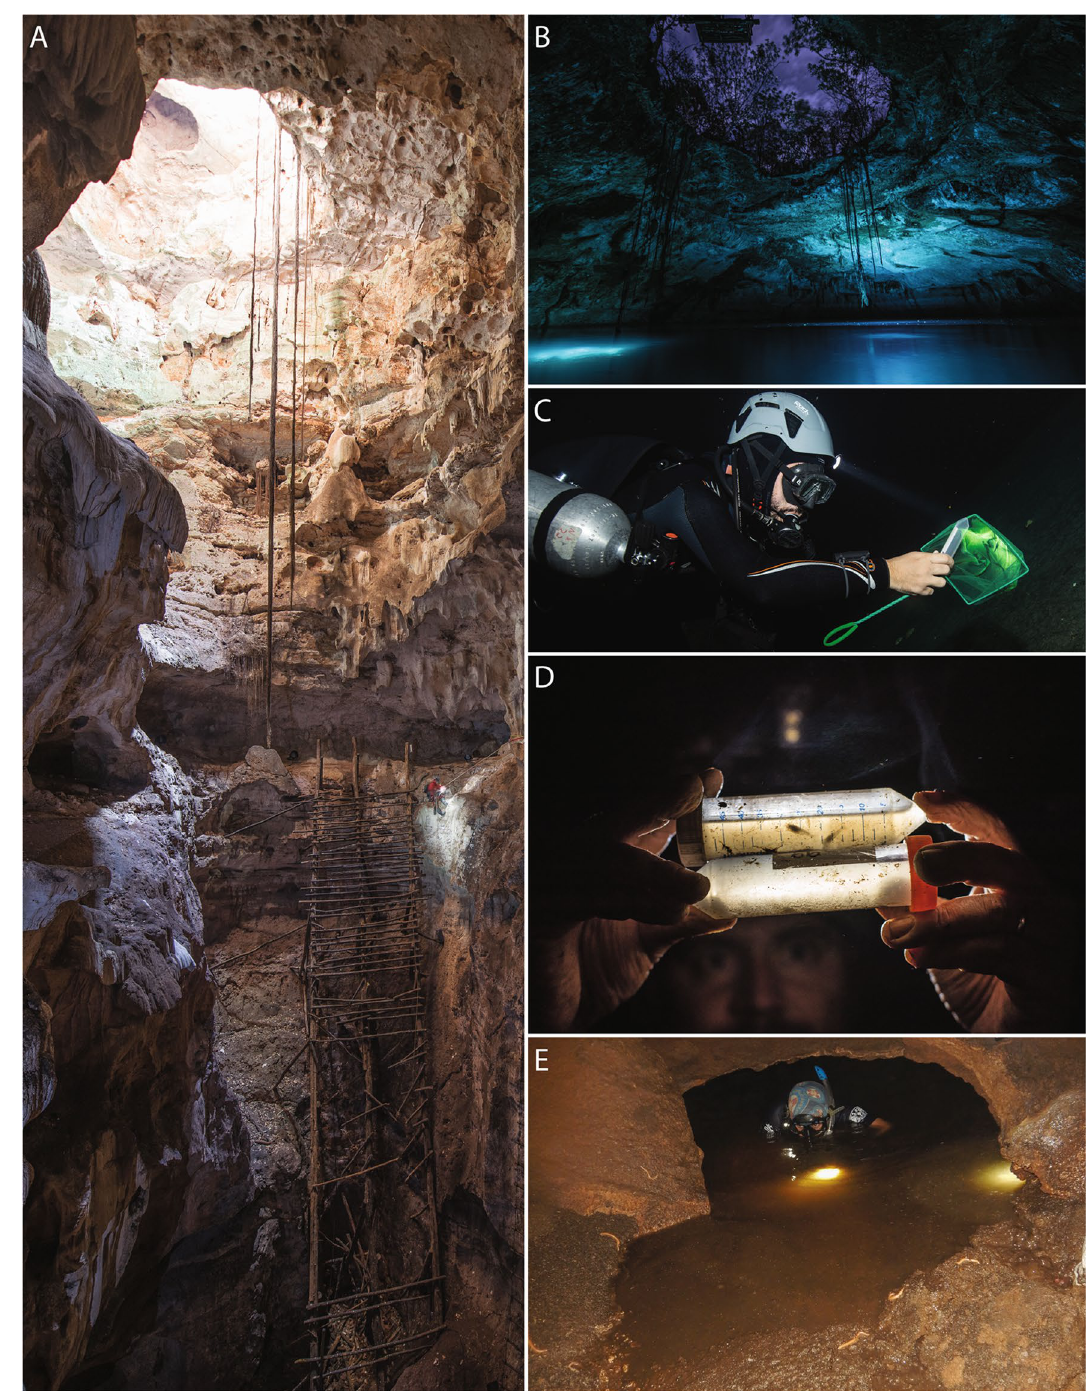
Figure 1. Select field sites and sampling of Typhlatya specimens within the Yucatán Peninsula. ( A ) Entrance to Grutas de Xtacumbilxunam (Campeche State), showing pit-style inland cenote ; depth ~ 60 m; note replica of wooden ladder used by Mayans to access aquifer; ( B ) Cenote Noh-Mozon (Yucatán State), inland cave, and collection site of Typhlatya pearsei ; ( C ) Cave diver (ECS) collection of Typhlatya mitchelli within Cenote Tza Itza (inland, Yucatán State) using catch net and falcon tube; ( D ) post collection (by ECS) of Typhlatya campecheae within Grutas de Xtacumbilxunam, type locality; ( E ) Cave diver (ECS) emerging from freshwater entrance pool within Grutas de Xtacumbilxunam; collection site of Typhlatya campecheae . Images: ( A–D ) Kay Vilchis; ( E ) Erick